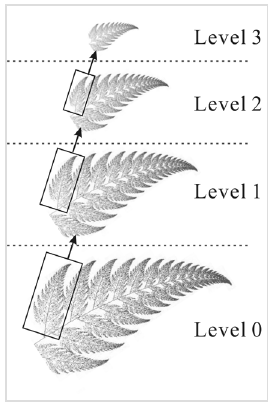
Figure 1. Self-similarity between